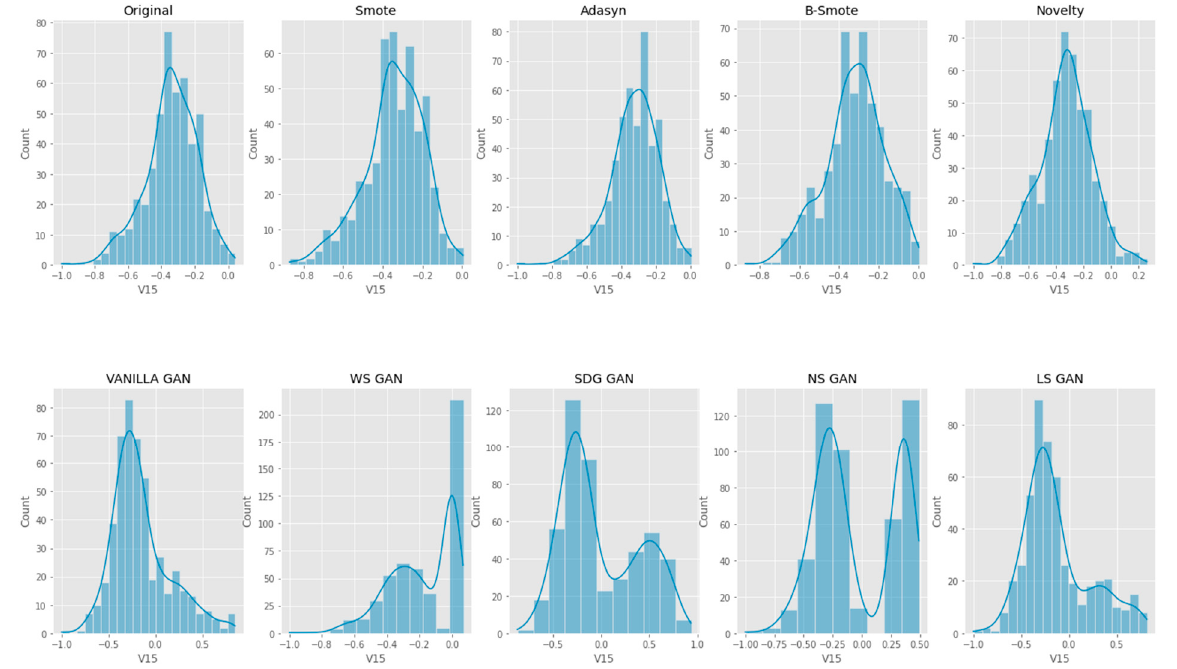
Figure 16. Univariate V15 Feature Distribution comparison of Original Data, SMOTE, ADAYSN, B-SMOTE, Novelty K-CGAN, Vanilla GAN, WS GAN, SDG GAN, NS GAN, and LS GAN methods.